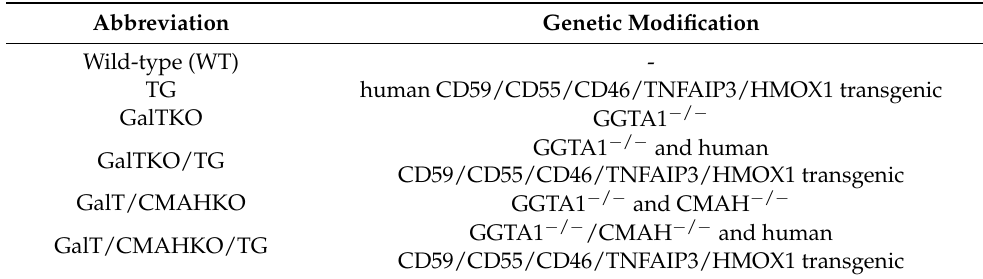
Table 1. Genetic modifications and abbreviation used for transgenic Sus